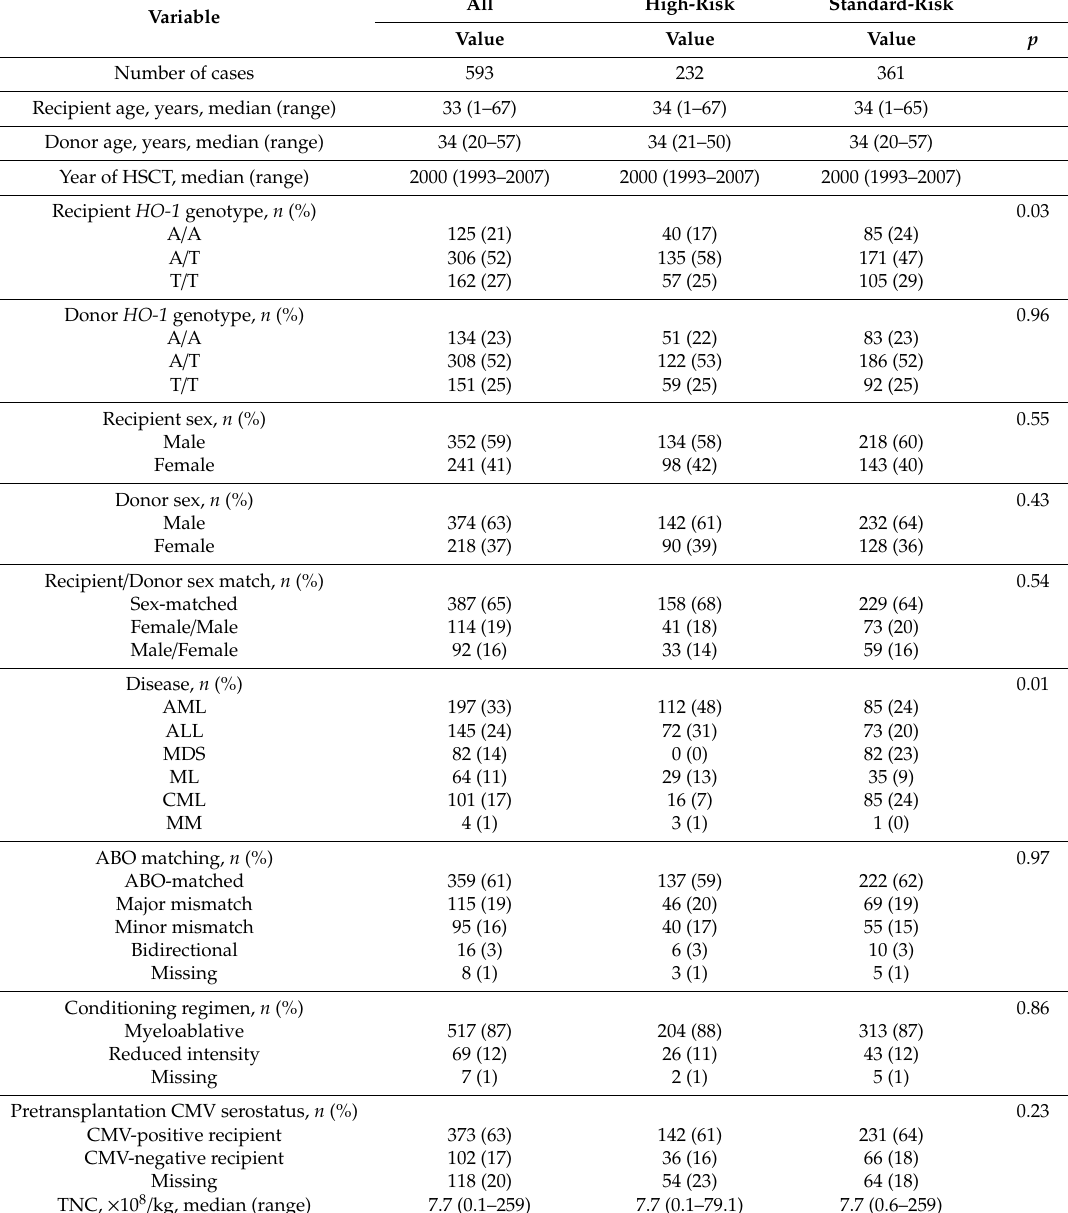
Table 1. Characteristics and heme oxygenase-1 ( HO-1 ) genotypes of recipients and donors, according to the disease